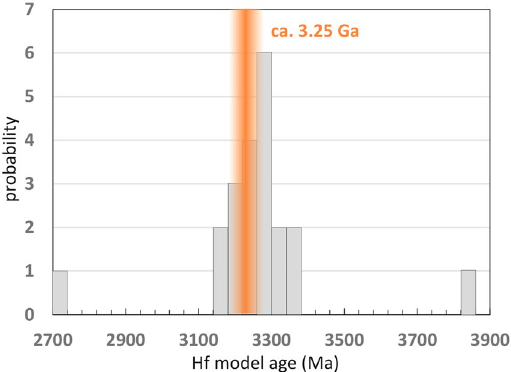
Figure 3. Probability plot of the Hf model ages for the Pilbara black shale samples. The peak around 3.25 Ga indicates a common source region for all